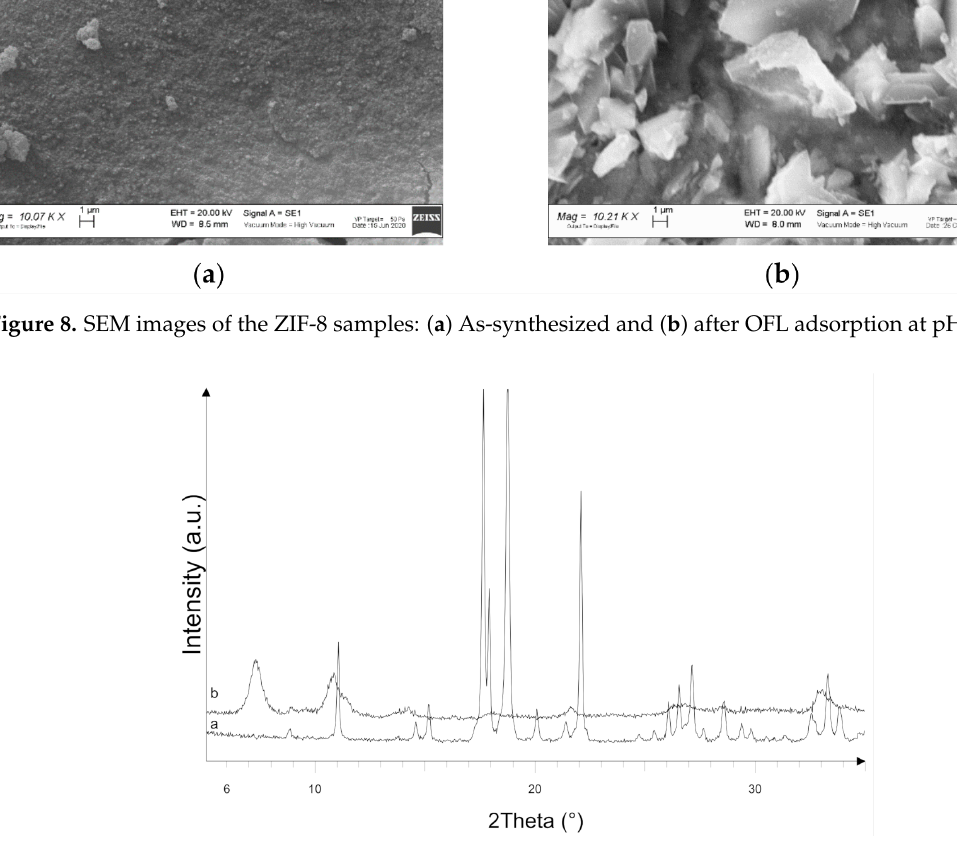
Figure 9. XRPD patterns of Zn 3 (BTC) 2 : As-synthesized (pattern a) and after OFL adsorption in tap water (pattern b).